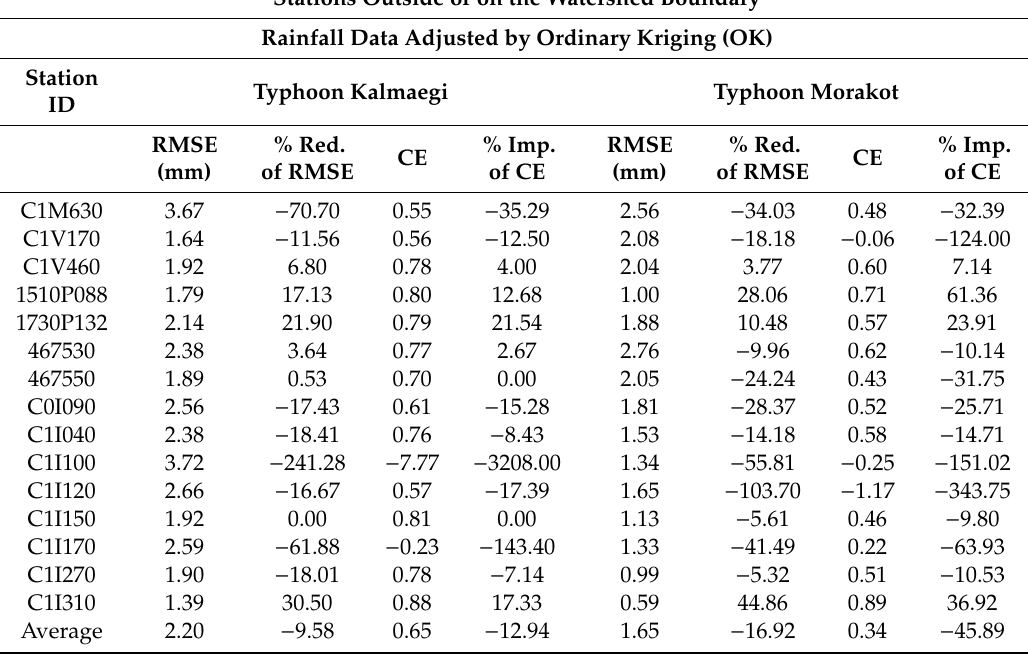
Table 4. RMSE and CE for the adjusted radar rainfall values using OK for stations outside or on the watershed boundary during the events of typhoons Kalmaegi and Morakot. The values of the percentage reduction (% Red.) in the RMSE and percentage improvement (% Imp.) in CE are also included. The values at station C1I100 were not used in the calculation of the averaged values for Typhoon